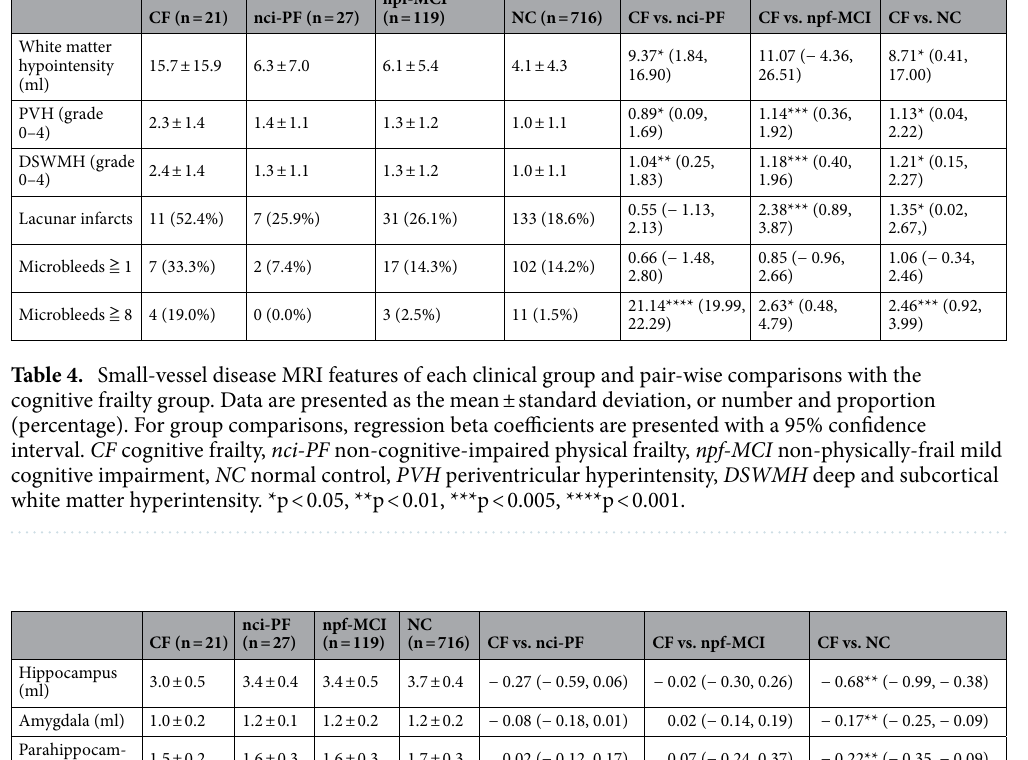
Table 5. Medial temporal lobe volumes of each clinical group and pair-wise comparisons with the cognitive frailty group. The average volumes of the left and right regions were calculated. Data are presented as the mean ± standard deviation. For group comparisons, regression beta coefficients are presented with a 95% confidence interval. CF cognitive frailty, nci-PF non-cognitive-impaired physical frailty, npf-MCI non- physically-frail mild cognitive impairment, NC normal control. *p < 0.05, **p < 0.001.